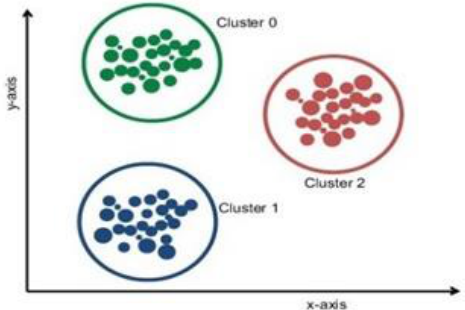
Figure 2. Measuring the closeness of agents based on Euclidean distance